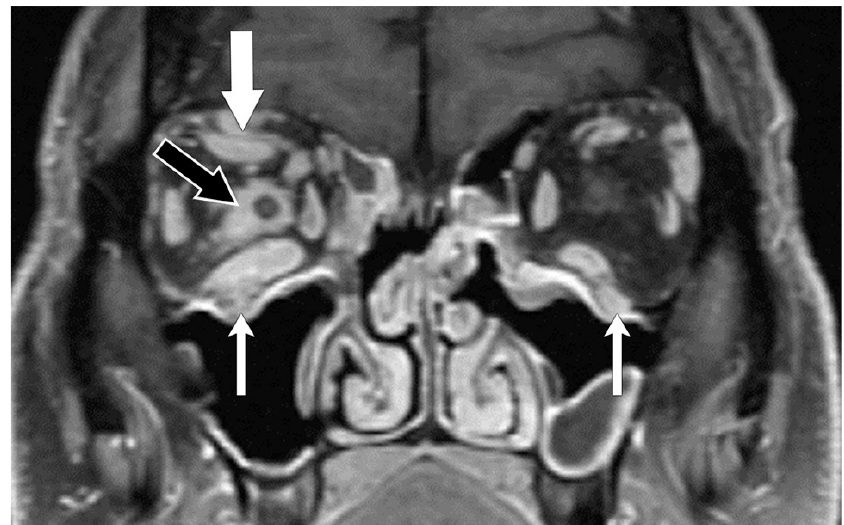
Figure 4. IgG4-related disease. Coronal T1 post-contrast MR sequence shows enlargement of the right superior rectus–levator complex (thick white arrow) and the inferior rectus muscle. Enhancing disease is also present around the optic nerve (black arrow) and seen involving the infra-orbital nerves bilaterally (V 2 ) (thin white arrows).